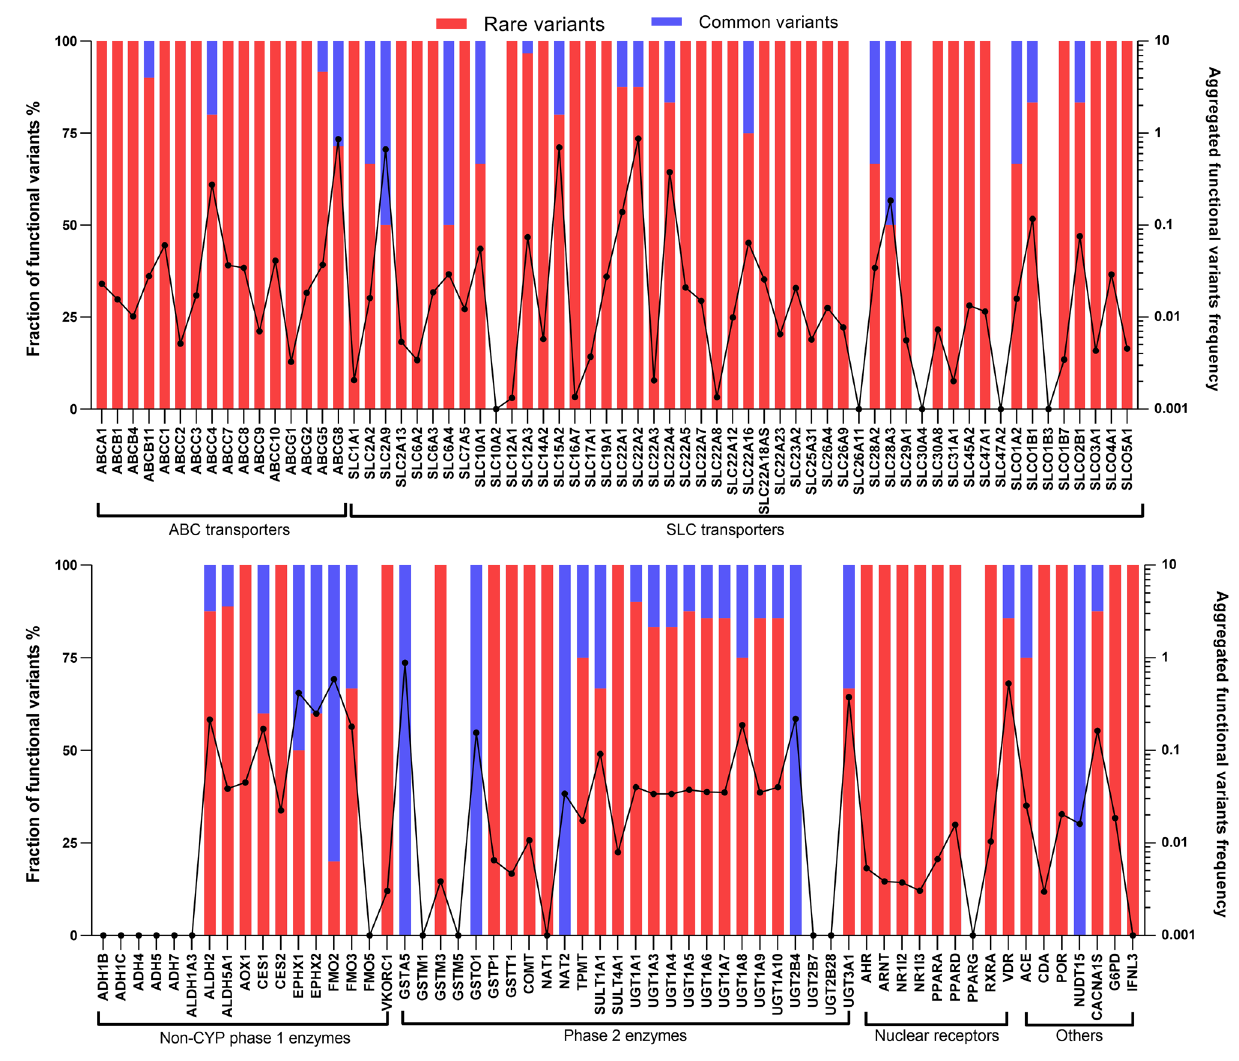
2 enzymes, nuclear receptors, and others pharmacogenes is plotted in log scale and indicated as dots connected by the black line (right y-axis). The fraction of the functional variation that is allotted to common (blue) or rare (red) variants is indicated on the left